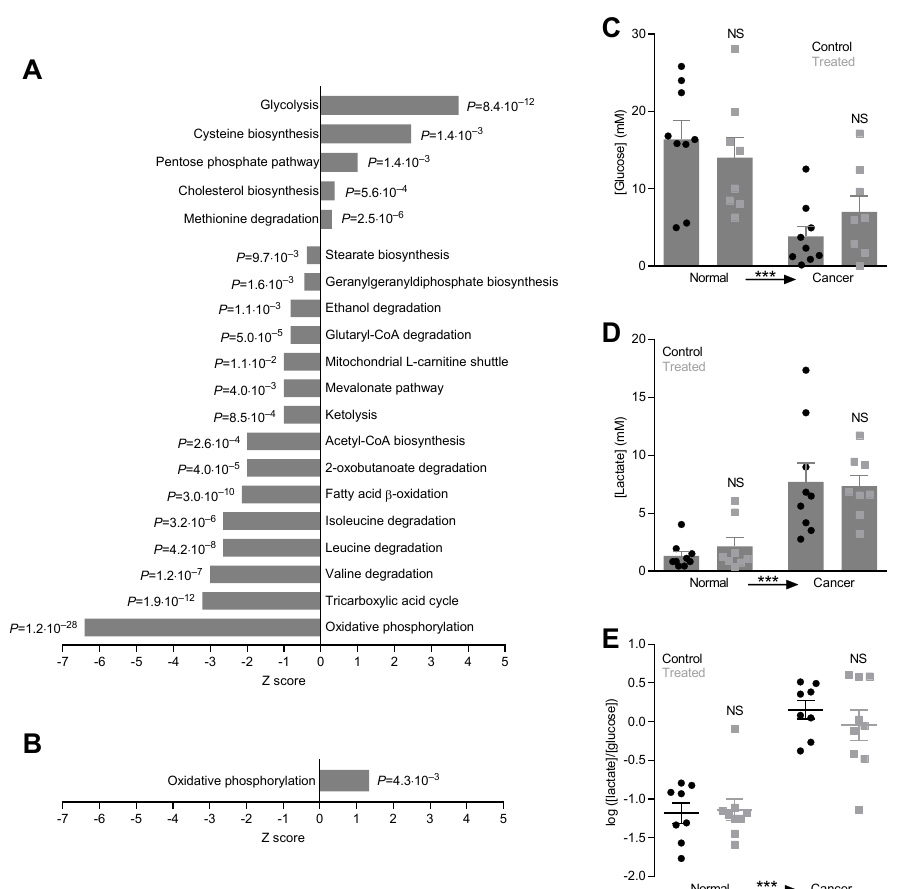
Figure 3. Metabolic pathways are dramatically perturbed during breast carcinogenesis but glycolytic metabolism in breast cancer tissue and normal breast tissue in vivo is una ff ected by oral NaHCO 3 therapy. ( A, B ). Protein expression changes for metabolic pathways. We compare breast cancer tissue vs. normal breast tissue from control mice ( A ) and breast cancer tissue from NaHCO 3 -treated mice vs. control mice ( B ). p -values were calculated based on Fisher’s right-tailed exact test. ( C–E ) . Interstitial concentrations of glucose ( C ) and lactate ( D ) and corresponding [glucose] / [lactate]-ratios ( E ) measured in microdialysis samples from breast cancer tissue and matched normal breast tissue of NaHCO 3 -treated mice and control mice ( n = 8–9). Data were compared by repeated measures to-way ANOVA followed by Sidak’s post-tests. NS: not significantly di ff erent vs. Control. *** p <